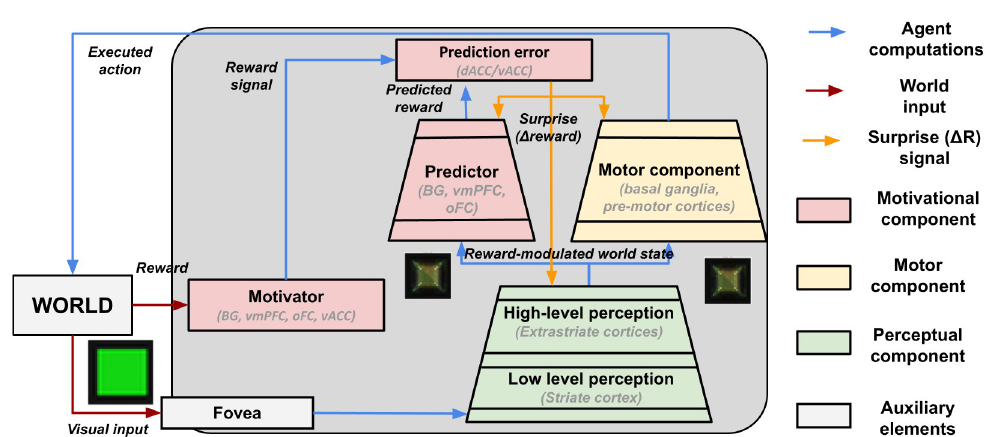
Fig 3. Schema of the model components and functions, the flows of information between the components, and the learning signals.